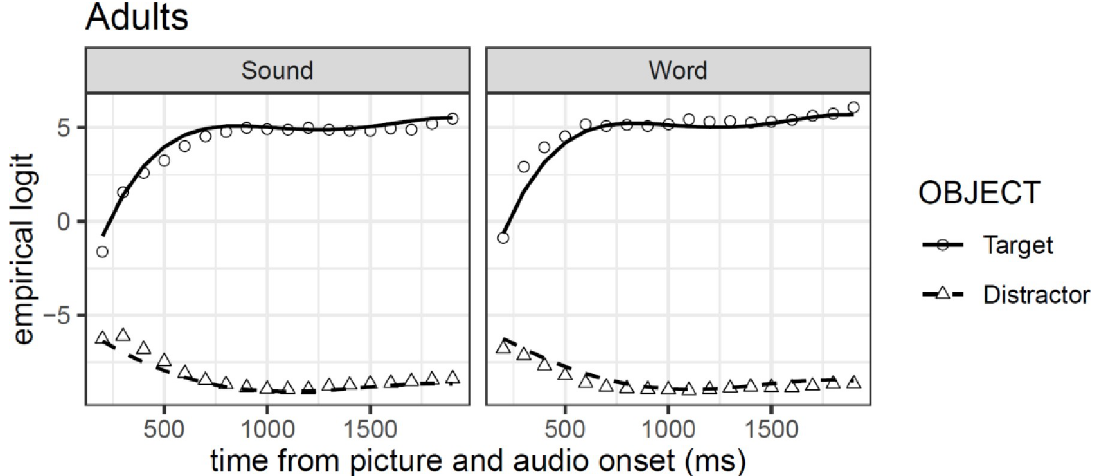
Fig 4. GCA model fit (lines) of empirical logit (points) as a function of object in the visual context and type of auditory stimulus in Experiment 1B.